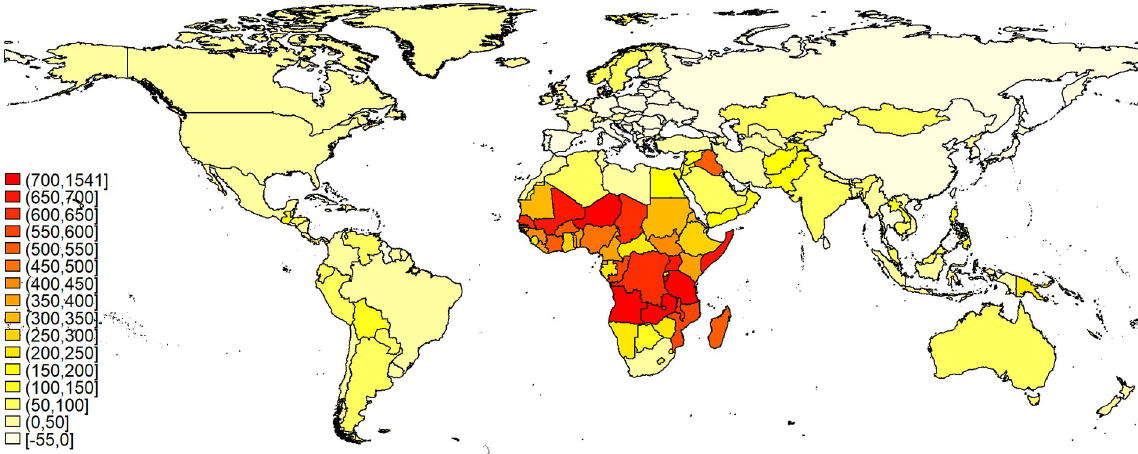
Fig 3. Relative change in national calorie requirements between 2010 and 2100 assuming increases in BMI and height (Scenario 4).